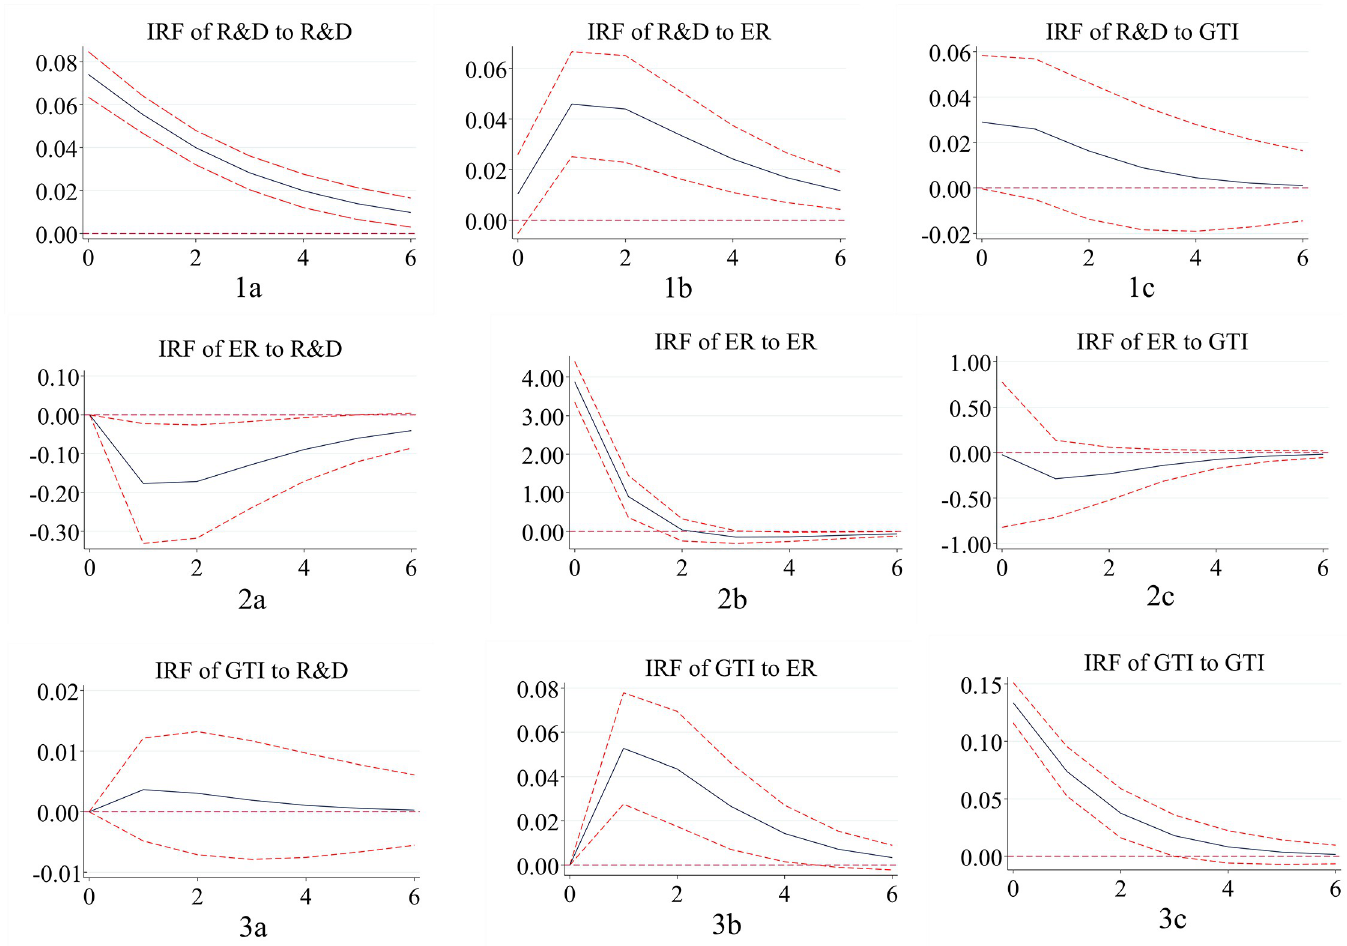
Fig 1. Impulse response in eastern China. Notes: The horizontal axis represents the number of lag periods (years), the middle curve is the impulse response function curve, and the upper and lower curves represent the 95% confidence interval.